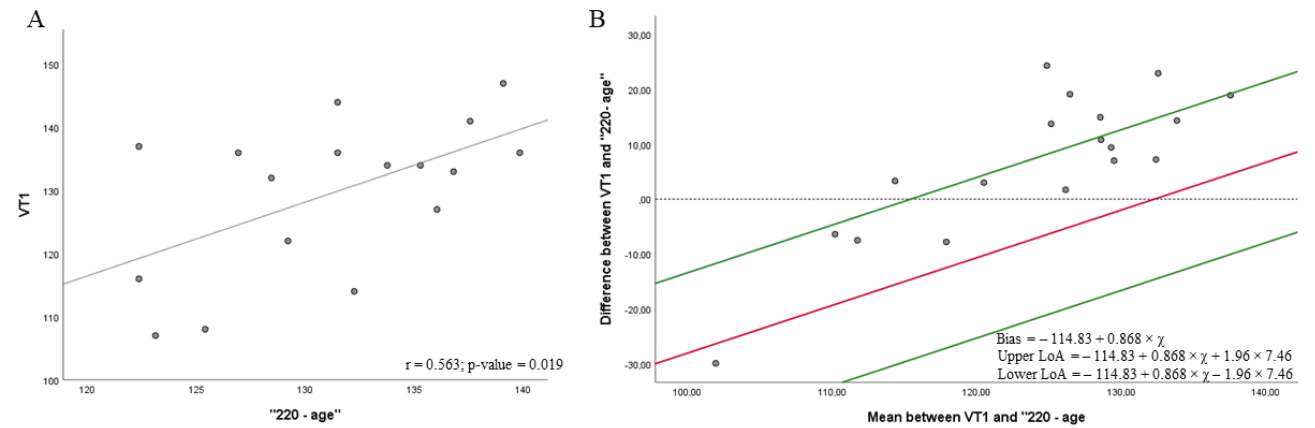
Figure 1. Correlations ( A ) and Bland–Altman plots ( B ) between the heart rate achieved in the VT1 in the cardiopulmonary exercise testing (CPET) and the mathematical model to predict the maximum heart rate “220 − age” at 76%.